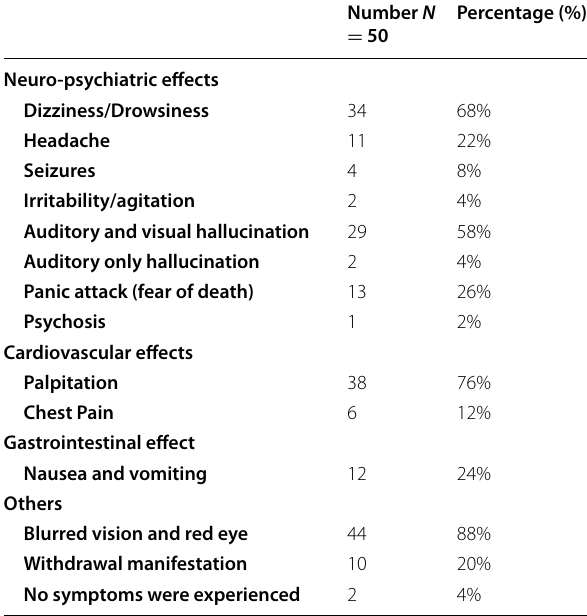
P value is significant at